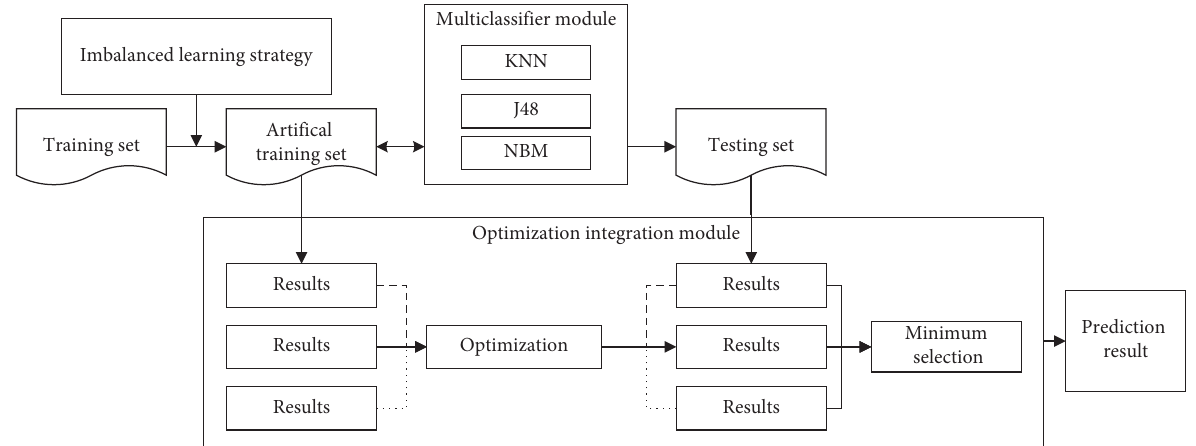
Figure 1: Overview of